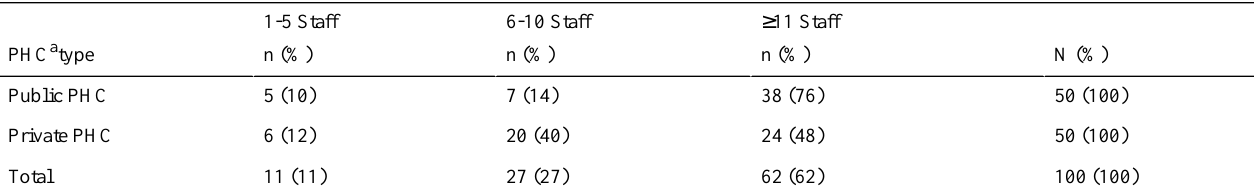
Table 2. PHC type and staff strength in Abuja (N=100).